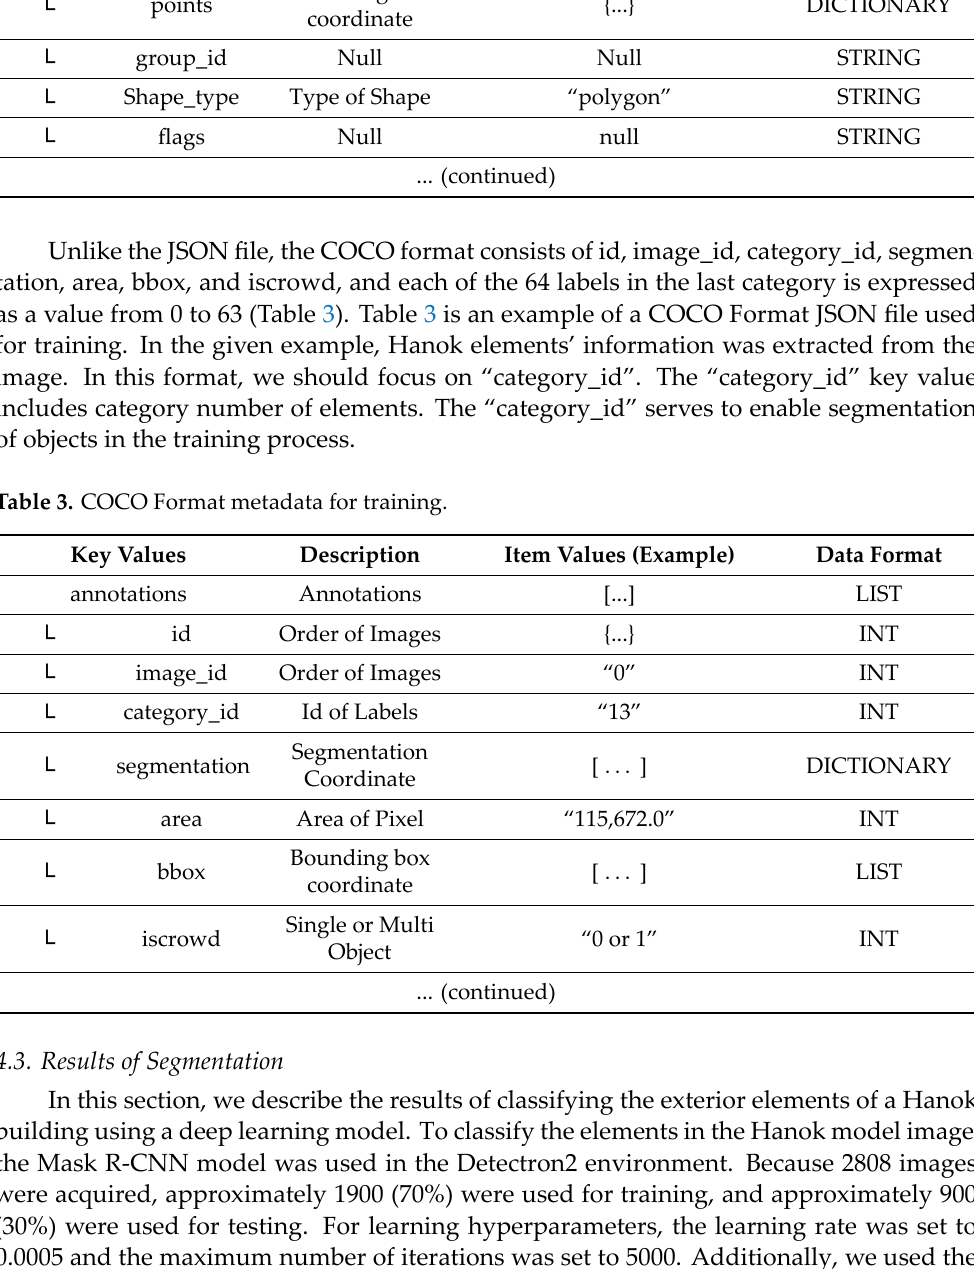
Table 2. JSON format metadata structure of labeled image.